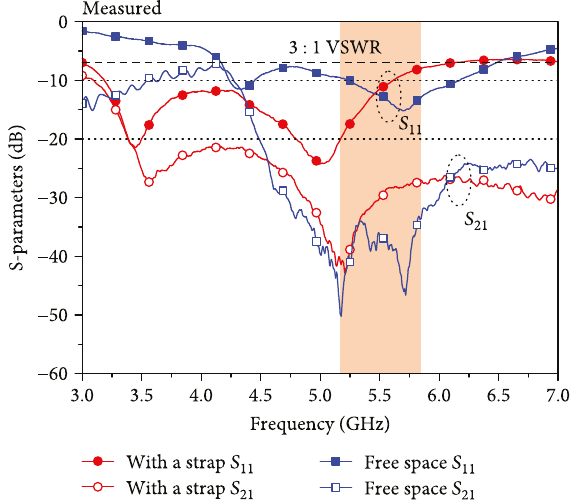
Figure 4: Measured S-parameters of the two-element MIMO antenna at the bending angle of 30 ° with and without the